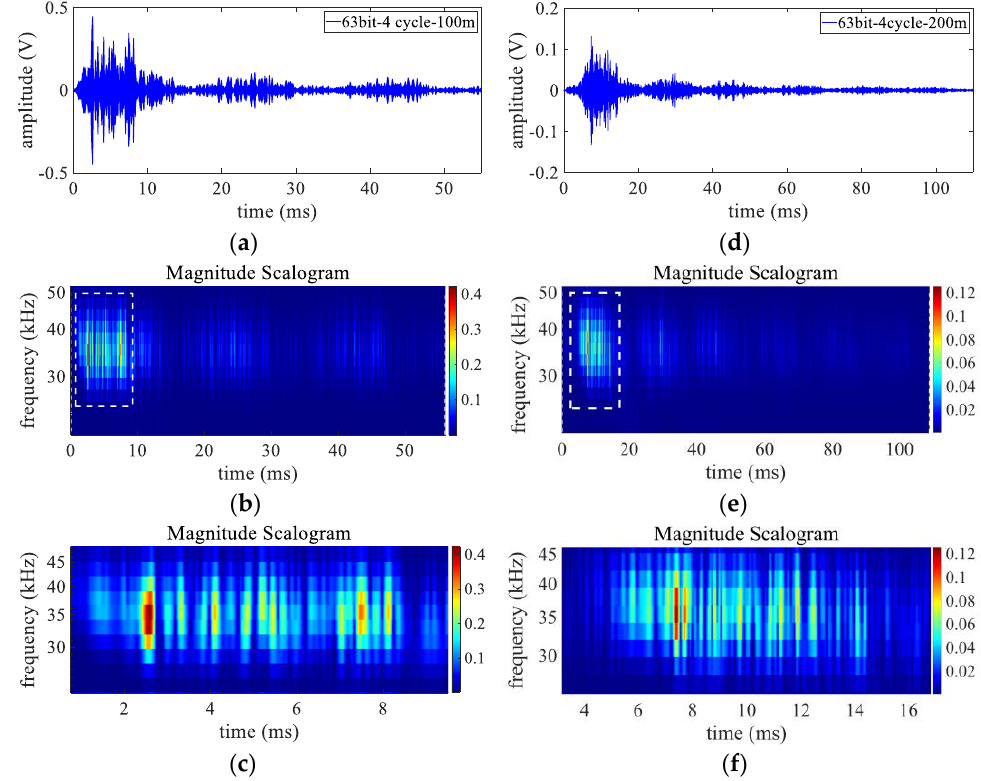
Figure 10. The received signals under encoding excitation by 63 − bit Kasami sequence, ( a ) the received signal under test distance equaling 100 m, ( b , c ) the corresponding time frequency analysis results, ( d ) the received signal under test distance equaling 200 m, ( e , f ) the corresponding time frequency analysis results.